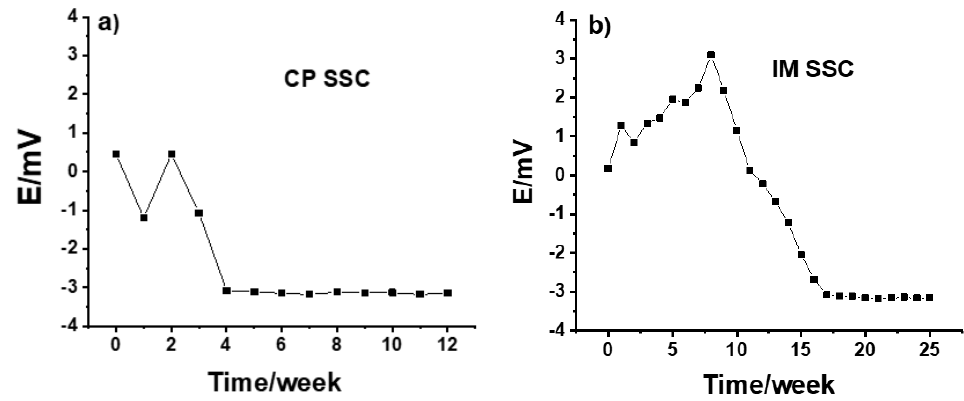
Figure 1. Potential stability of ( a ) CP SSC and ( b ) IM SSC electrodes measured in 10 − 1 MKCl .